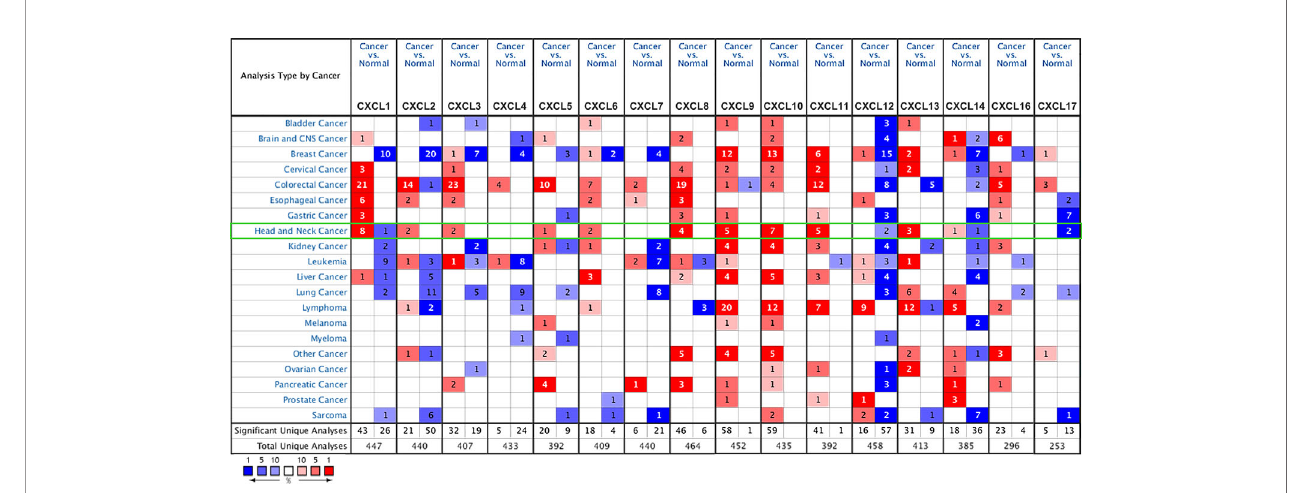
FIGURE 1 | The transcription of CXC chemokines in 20 different types of cancers